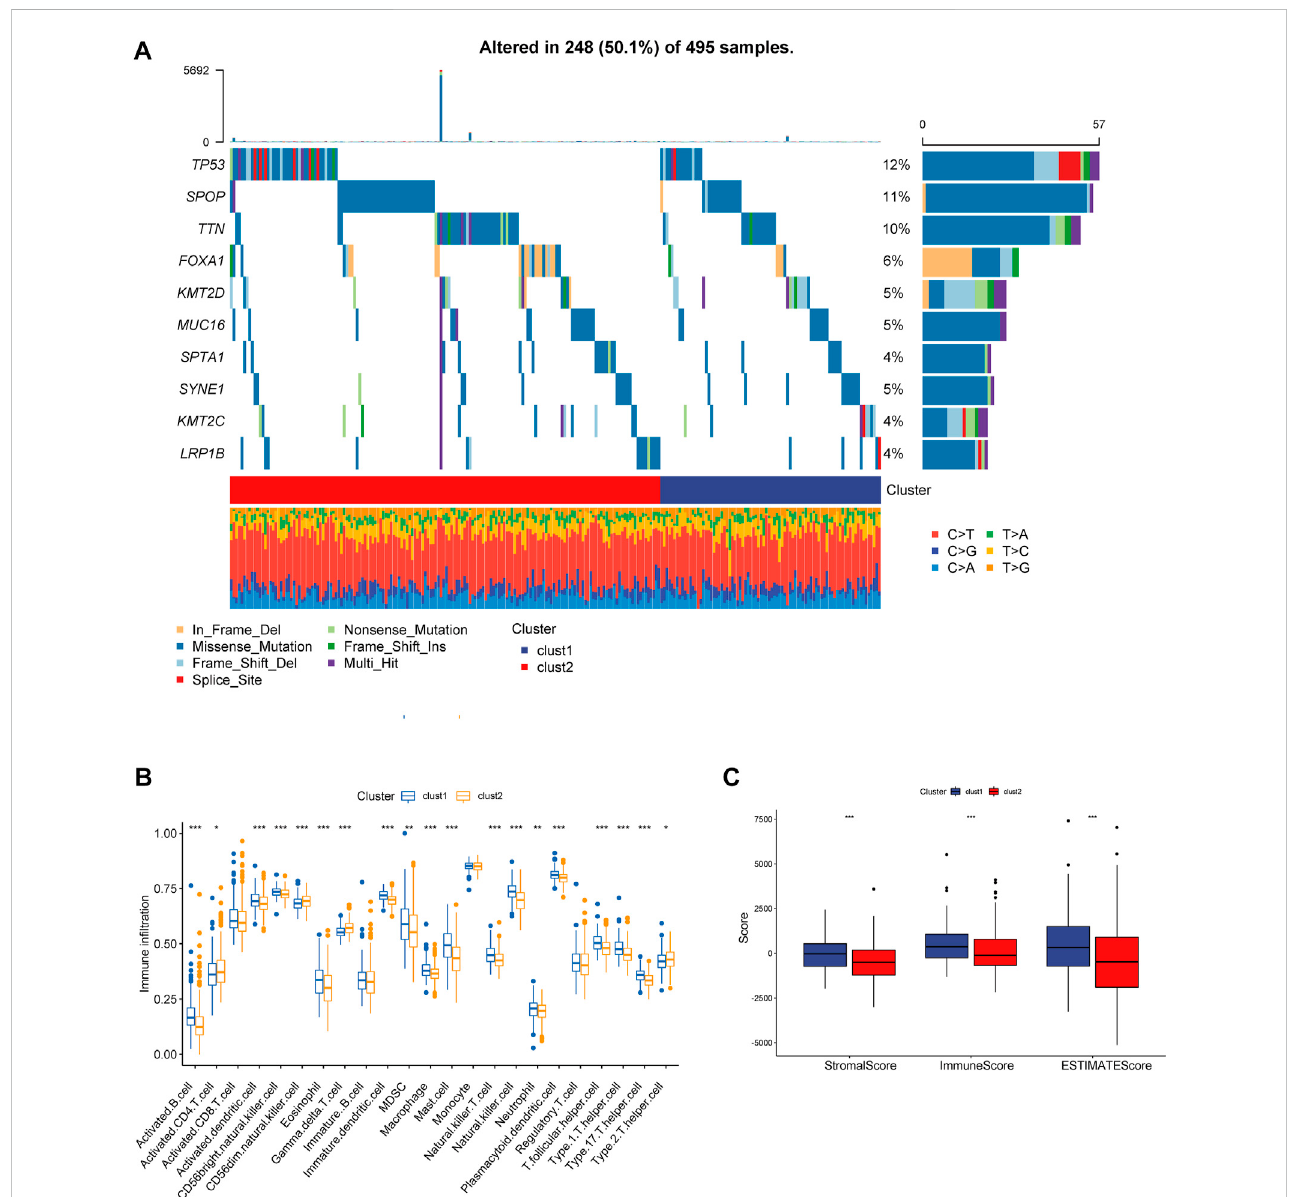
FIGURE 4 (A) Mutationinformationofthetop10mutationgenesispresentedinthewaterfallplot. (B,C) Boxplotpresentingtherelativeabundanceofimmunecells in the CRGs-related